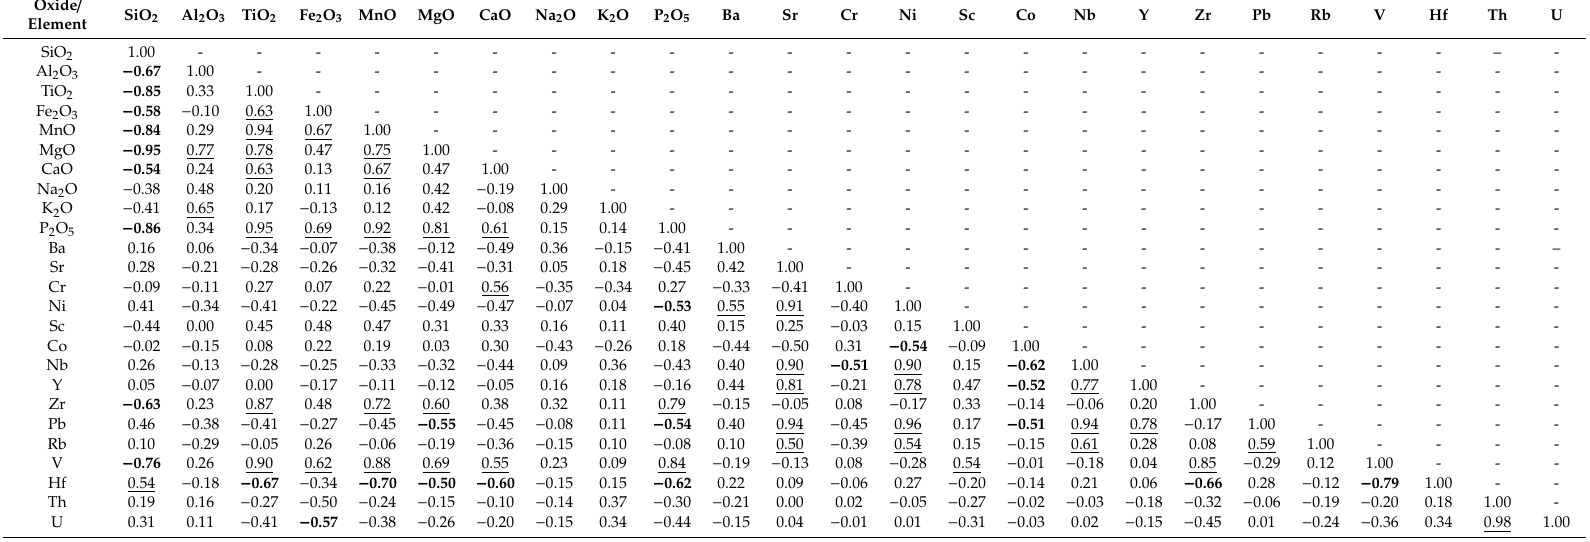
Table 4. Correlation matrix of major oxides and key trace elements for the Brahmaputra River sediments. Underscoring of coe ffi cients indicates a significant positive correlation, while a significant negative correlation is denoted by boldface